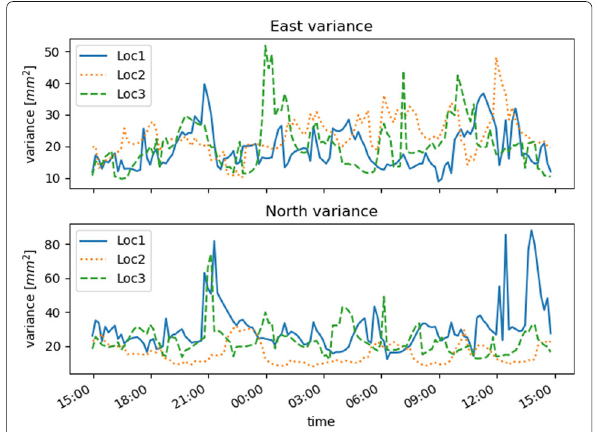
Fig. 16 Correlation time obtained on the basis of simulation results in Loc1 ,and for the static